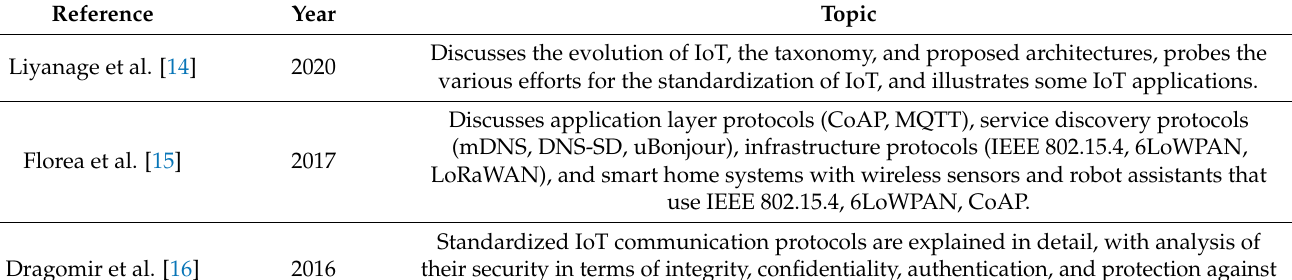
Table 1. Standardized protocols for IoT.